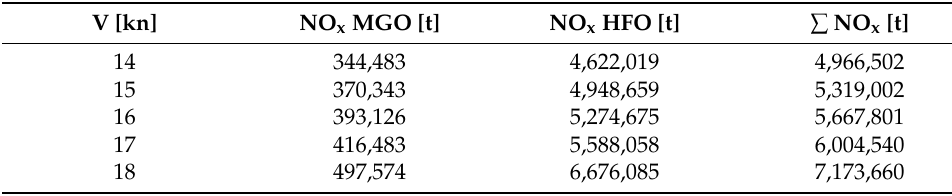
Table 8. Estimated amount of NO x emissions generated by container shipping in 2018.